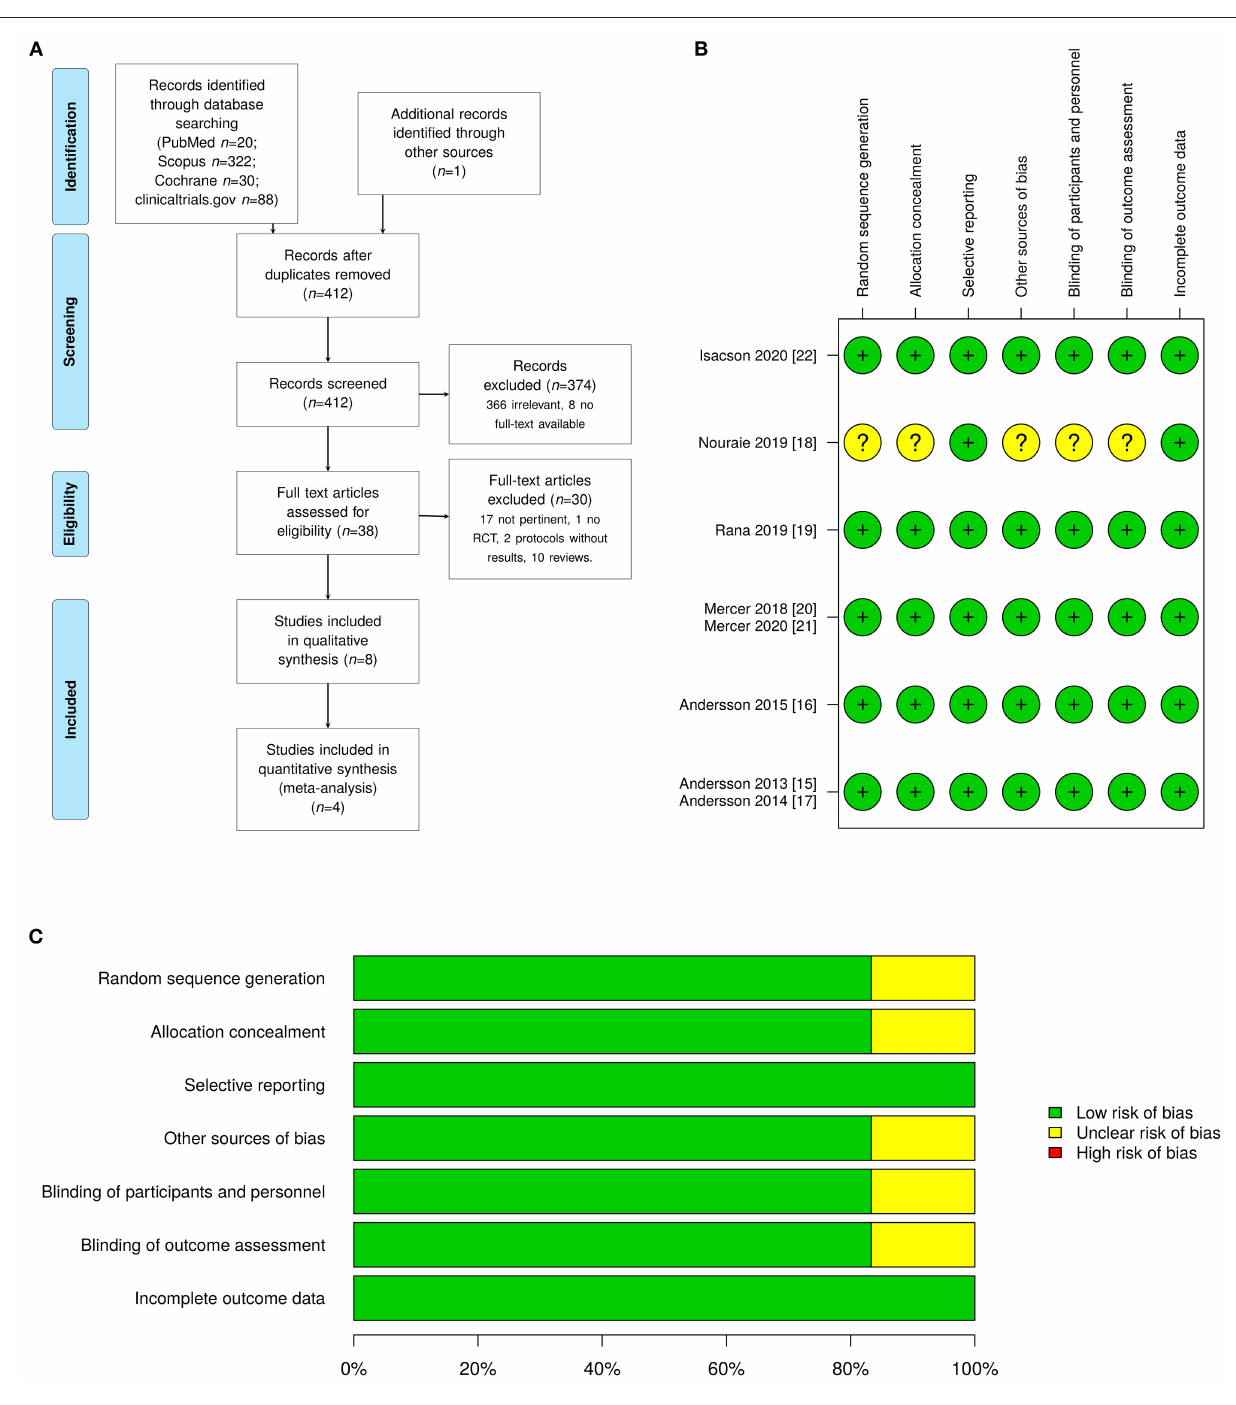
of T1 and T2) that was able to determine the myelin content